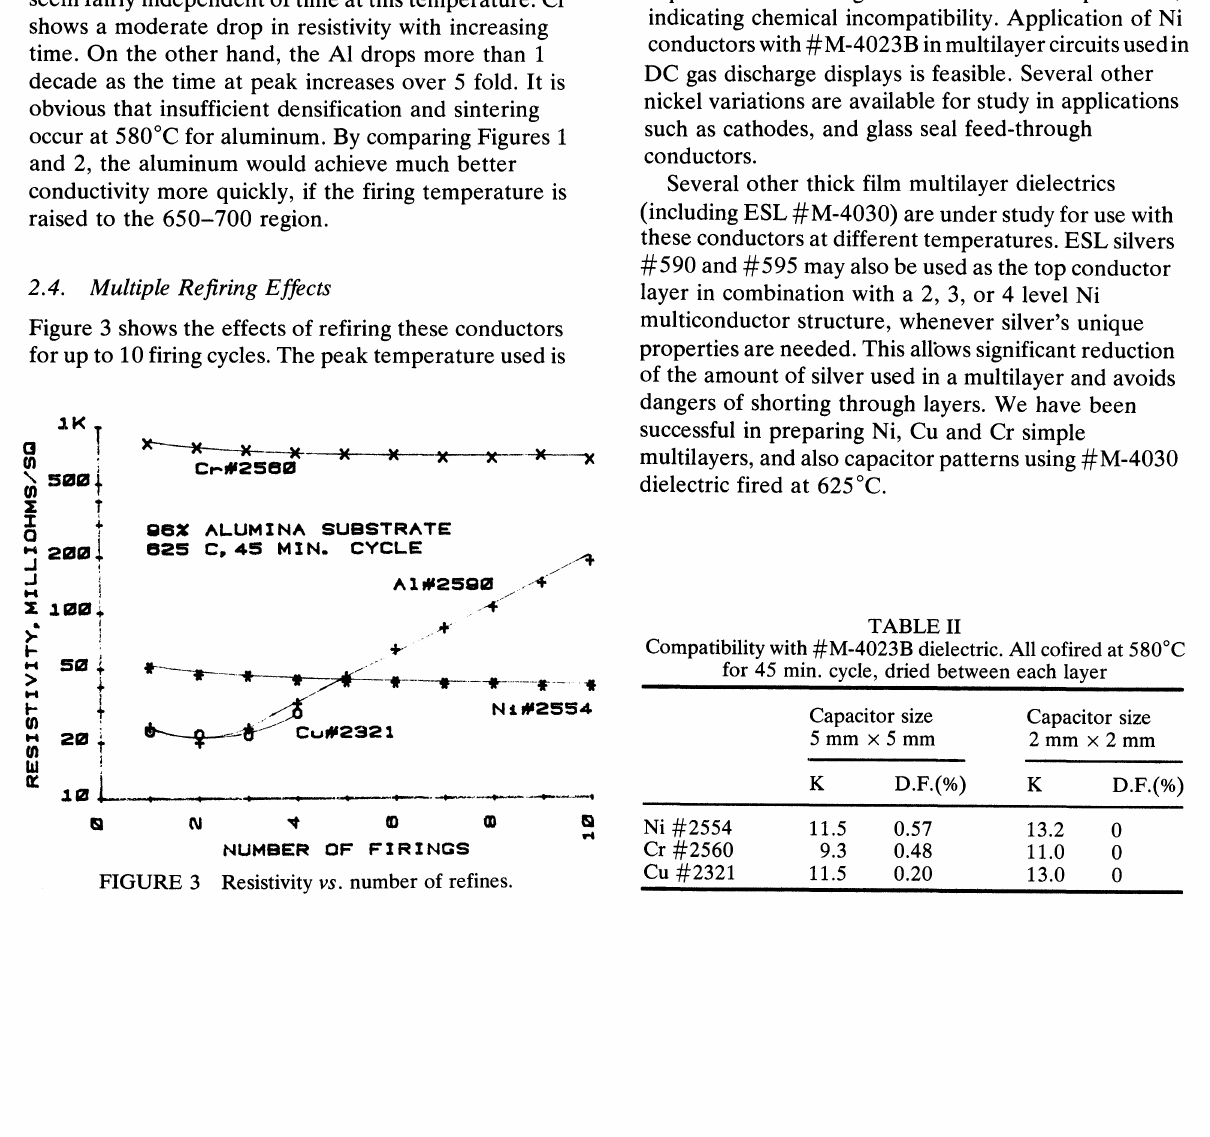
FIGURE 2 Resistivity vs. firing cycle time.